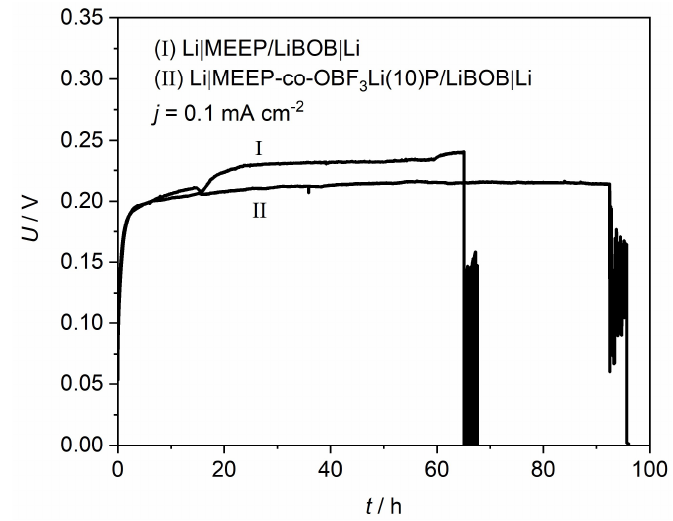
Figure 8. Constant current polarization curve of (I) Li|MEEP/LiBOB|Li and (II) Li|MEE- co -OBF 3 P/LiBOB|Li at 0.1 mA · cm − 2 , 60 ◦ C.